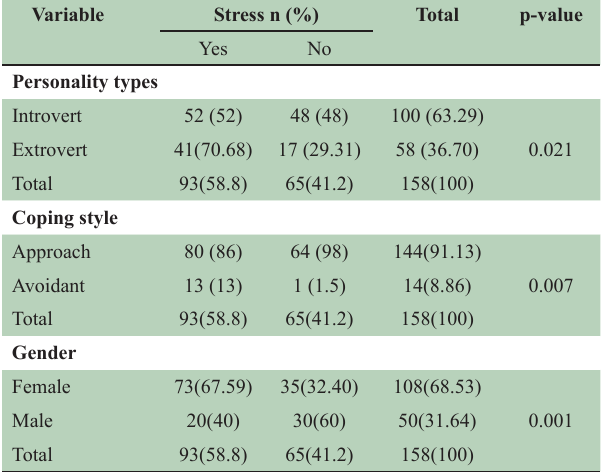
(p=0.001) (Table-I). However, we did not find any association between personality types & coping styles (p=0.936) (Table- II). Table-I: Association of Stress with personality types, coping style and gender.